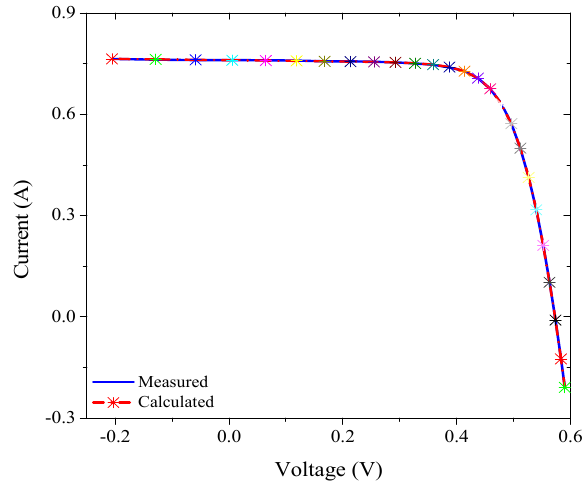
Figure 6. I–V curve of the measured and calculated currents for the single-diode